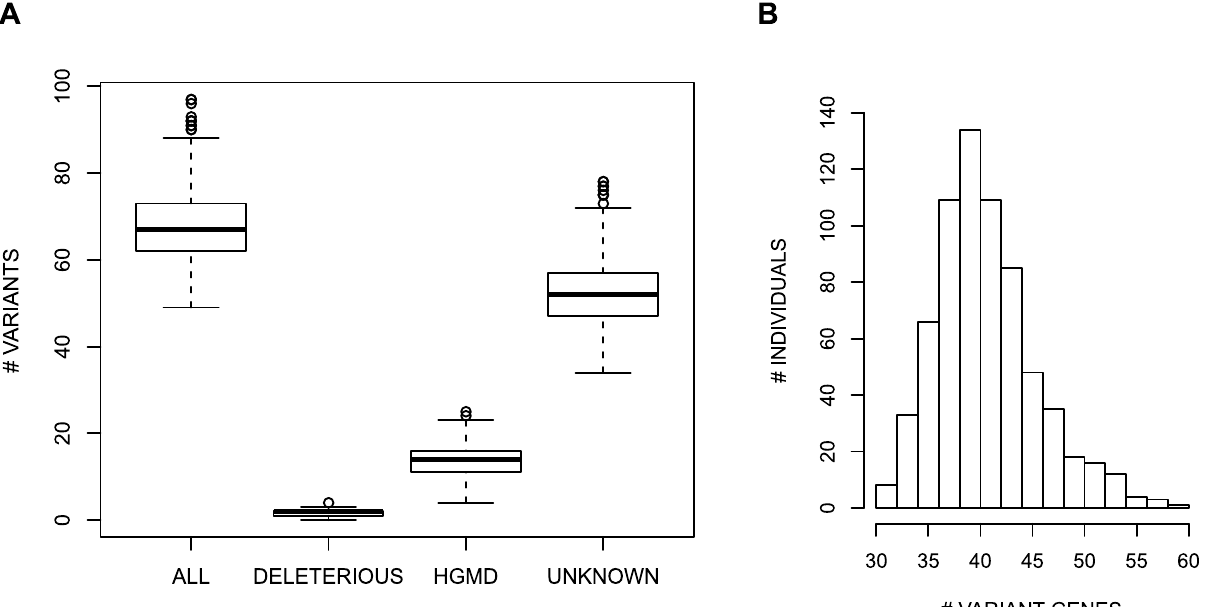
Figure 1. Profile of the variability per individual. (A) Boxplot of the total number of variants, the number of variants listed in HGMD, the number of likely deleterious variants, and the number of variants of unknown significance per individual for cancer-associated genes. (B) Distribution of the number of cancer genes with at least one nonsynonymous variant per individual.